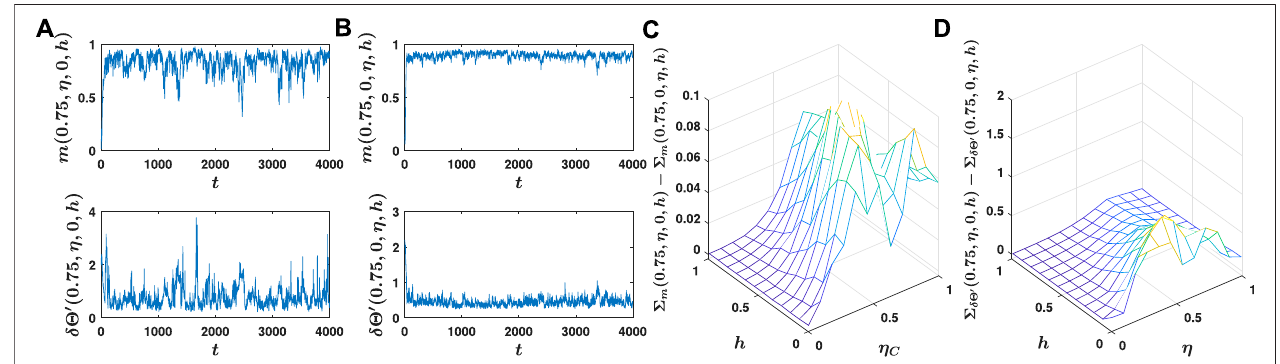
FIGURE 5 | Production noise increases temporal fl uctuations. (A) and (B) : m (top) and δ Θ ′ (bottom) for production noise (A) and comprehension noise (b) as a functionoftime. (C) and(d):Asymmetriesintemporal fl uctuationsin m (c)andin δ Θ ′ (D) in η − h planeareplotted.Productionnoiseincreasestemporal fl uctuations.In (A) and (B) η (cid:2) 0 . 46and h (cid:2) 0 . 28.In (C) and (D) ,thesimulationsarerunfor T (cid:2) 4000time steps,and standarddeviationsarecalculatedbasedonthelast2000timesteps. An average over 24 runs is taken. Here, L (cid:2) 10, v 0 (cid:2) 0 . 1, ω (cid:2) 0 . 25, η R (cid:2) 0 . 75 and ρ (cid:2) 1. ε is taken equal to π /